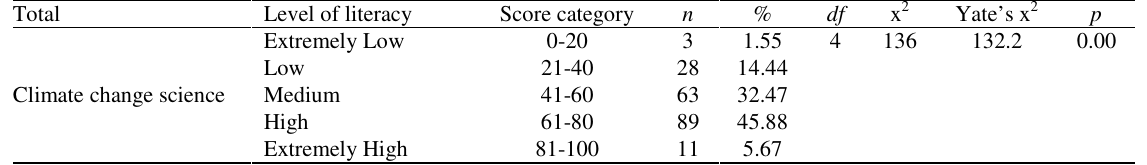
Table 4 Inferential analysis of the difference between the score frequencies on climate change science Total Level of